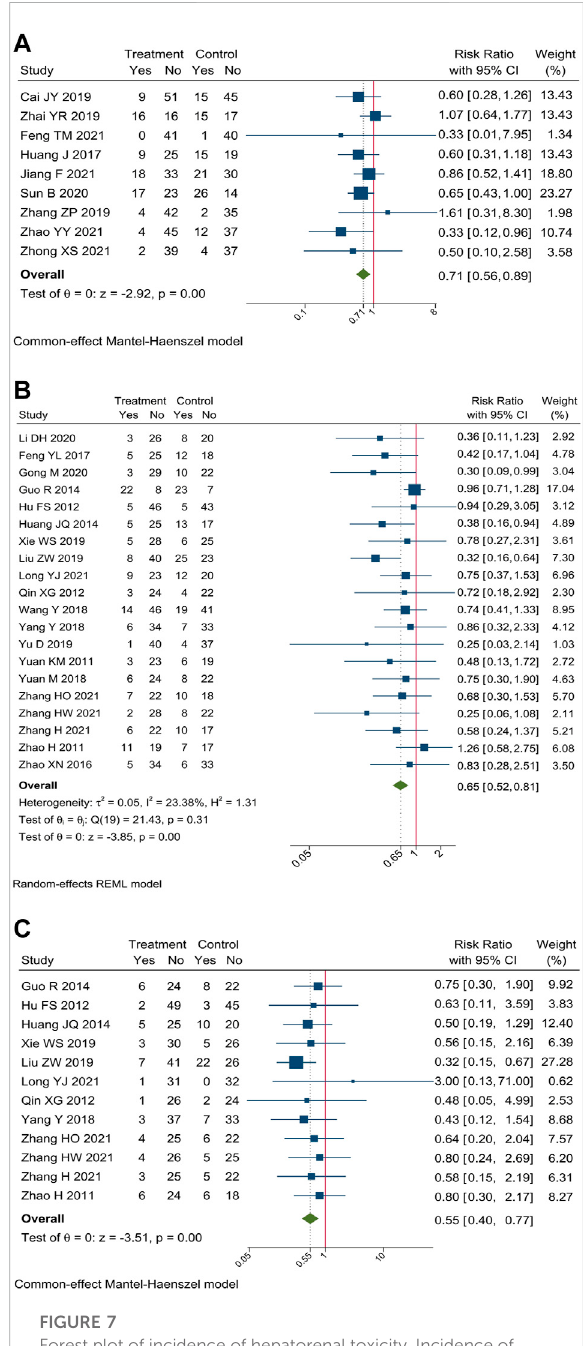
FIGURE 7 Forest plot of incidence of hepatorenal toxicity. Incidence